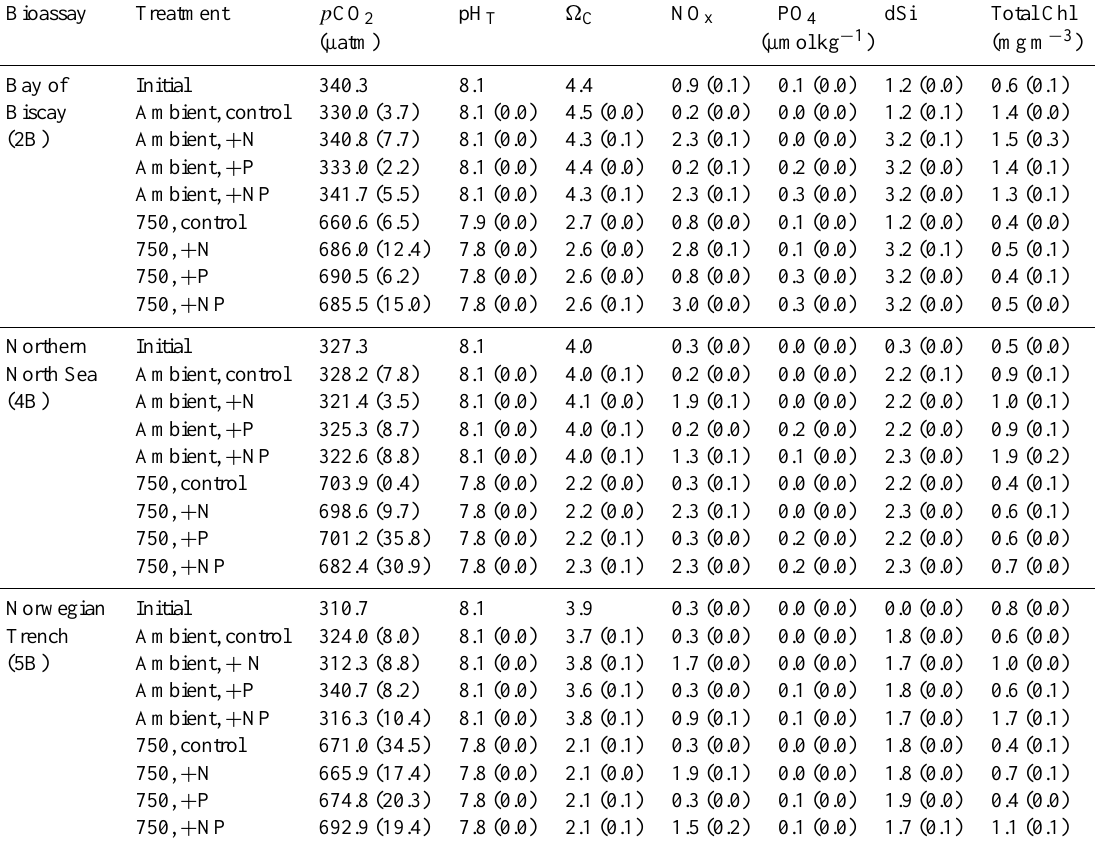
Table 5. Average ( ± sd) values for variables in the short-term (48h) bioassay experiments. Experimental treatments are as follows: + N is 2µmolkg − 1 nitrate and silicate; + P is 0.2µmolkg − 1 phosphate and 2µmolkg − 1 silicate; and + NP is 2µmolkg − 1 nitrate and silicate